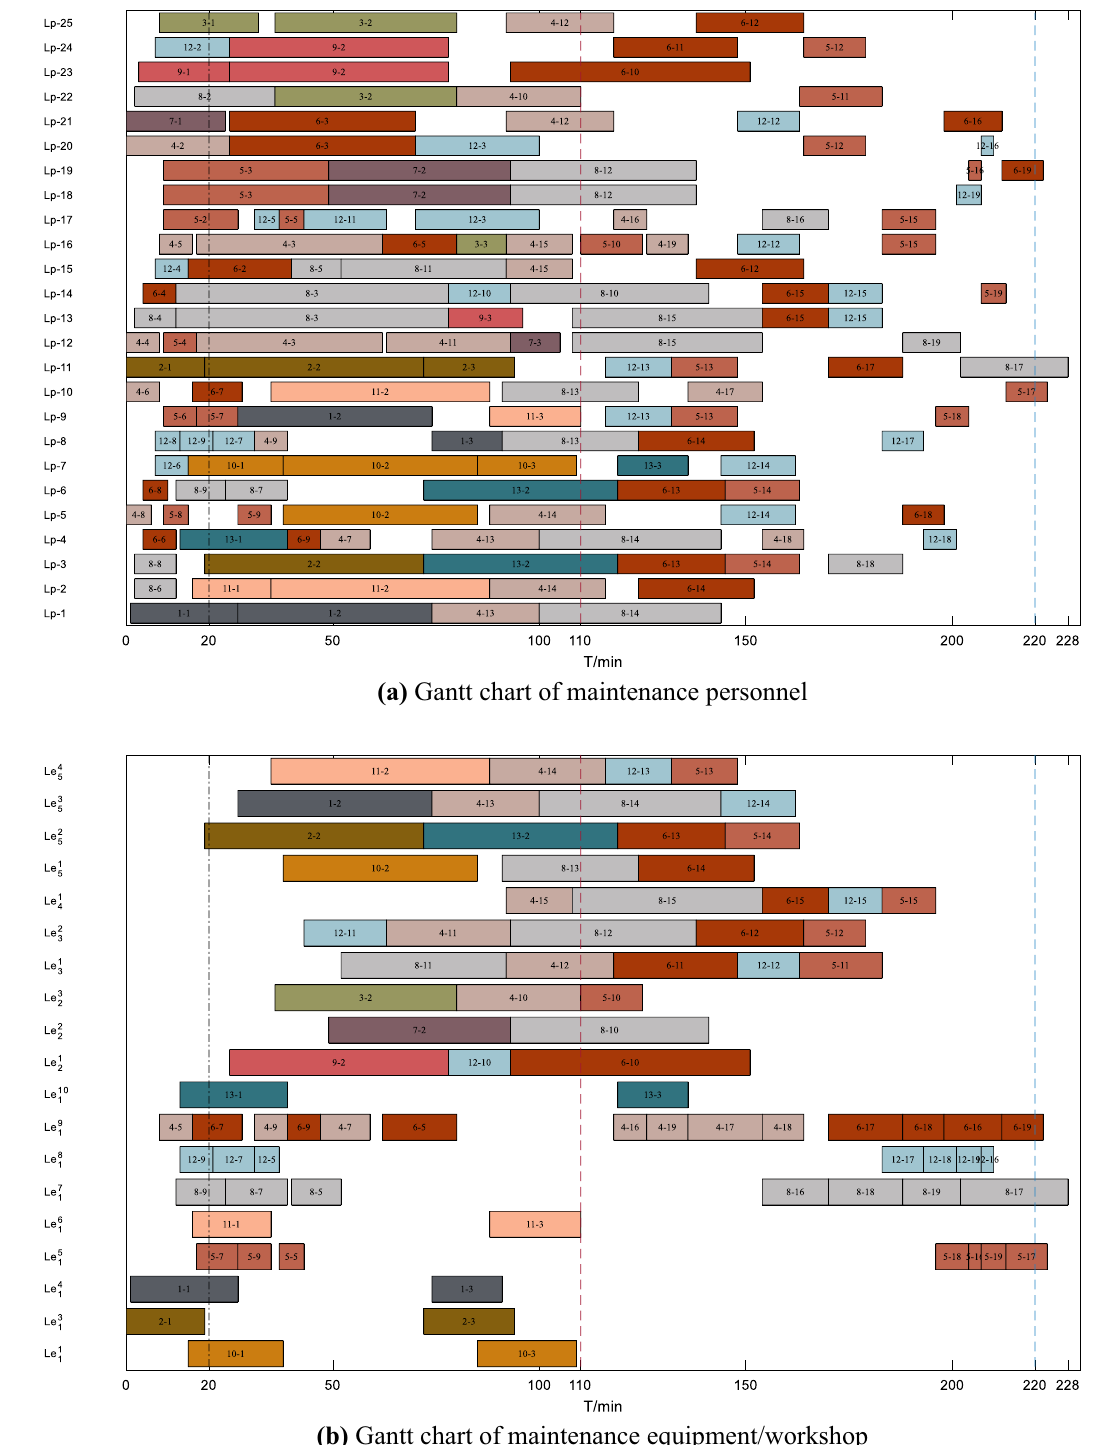
Fig. 16 Complete rescheduling of delay event II for 13 carrier-based